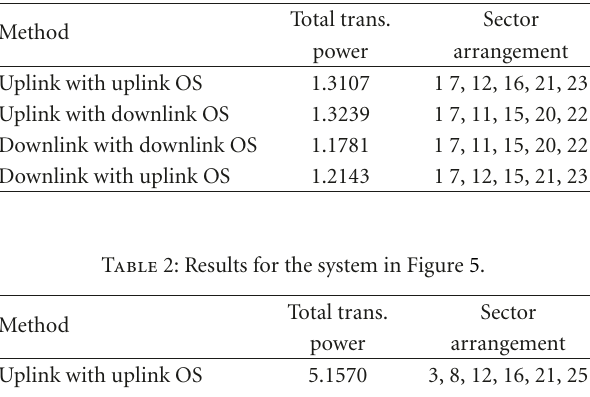
Table 1: Results for the system in Figure 4. Total transmit power is in watts.